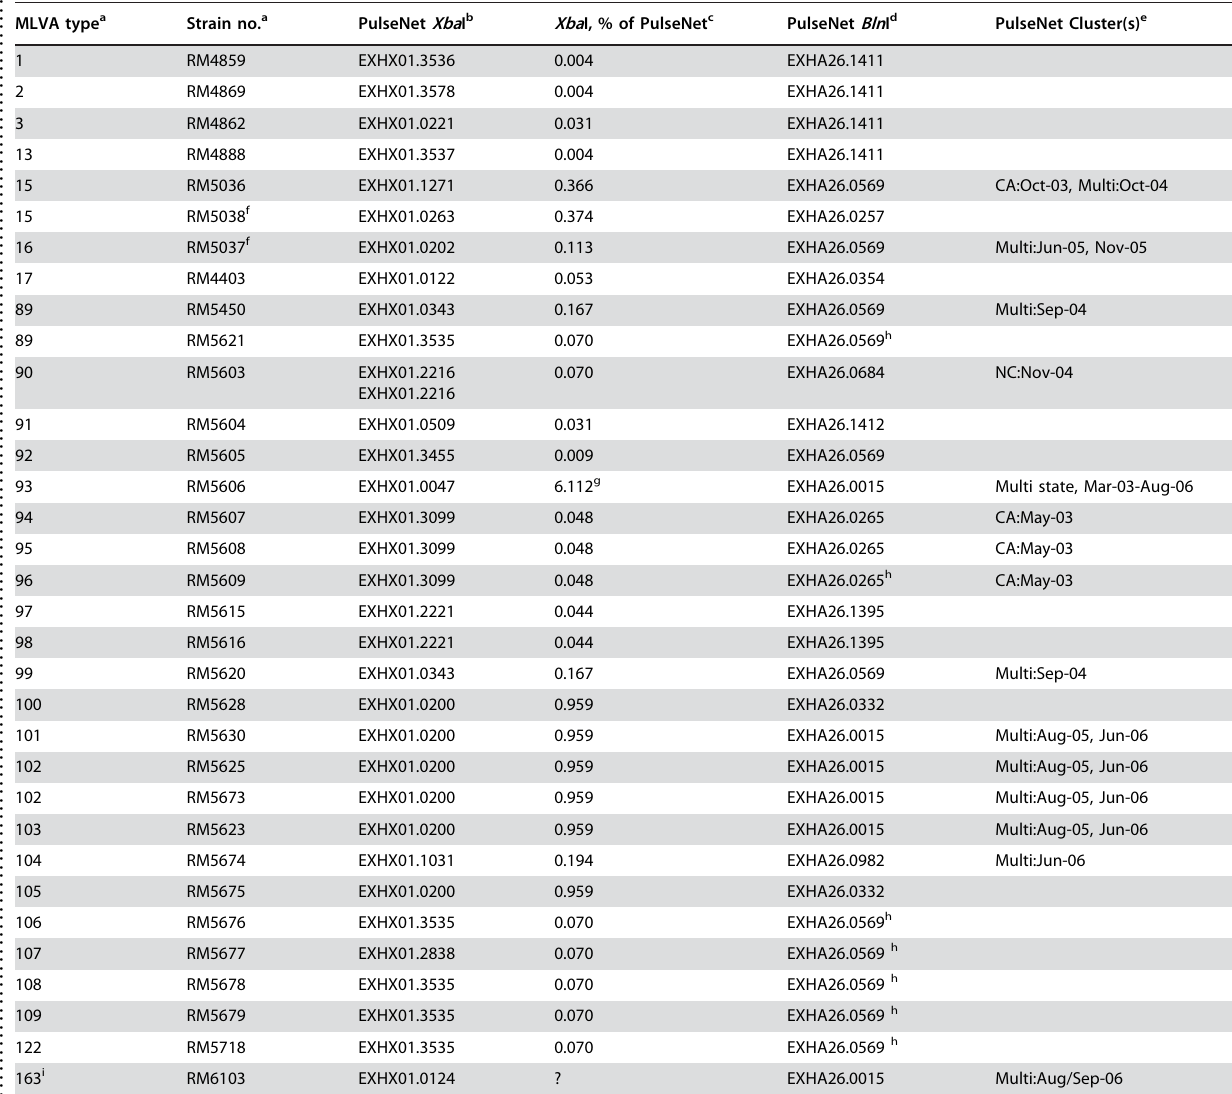
Table 1. Comparison of MLVA types of Ec O157 environmental strains with PFGE profile designations. .. ... .... ... ... .... ... ... .... ... ... .... ... ... .... ... ... .... ... ... .... ... ... .... ... ... .... ... ... .... ... ... .... ... ... .... ... ... .... ... ... .... ... ... . MLVA type